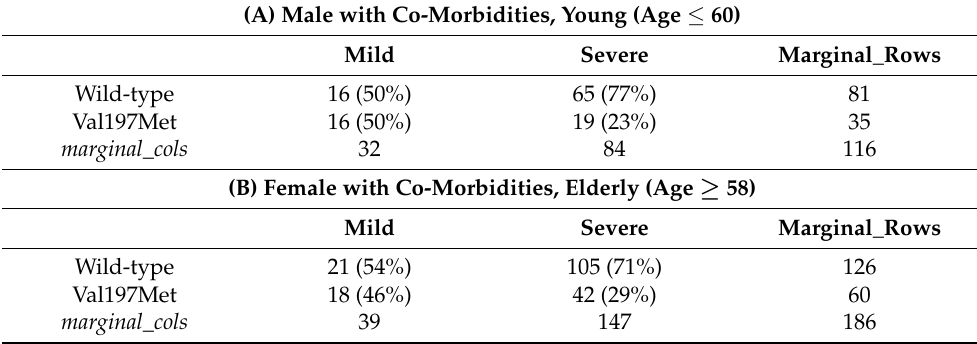
Table 3. Contingency tables of V197M TMPRSS2 in young males and elderly women affected by